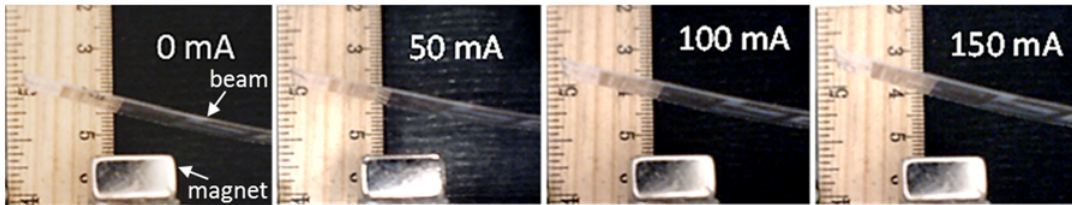
Figure 8. Frames grabbed by the camera showing the beam deflection for increasing values of the static driving current in the range [0–150] mA in case of a magnetic field B DC = 70.6 mT.